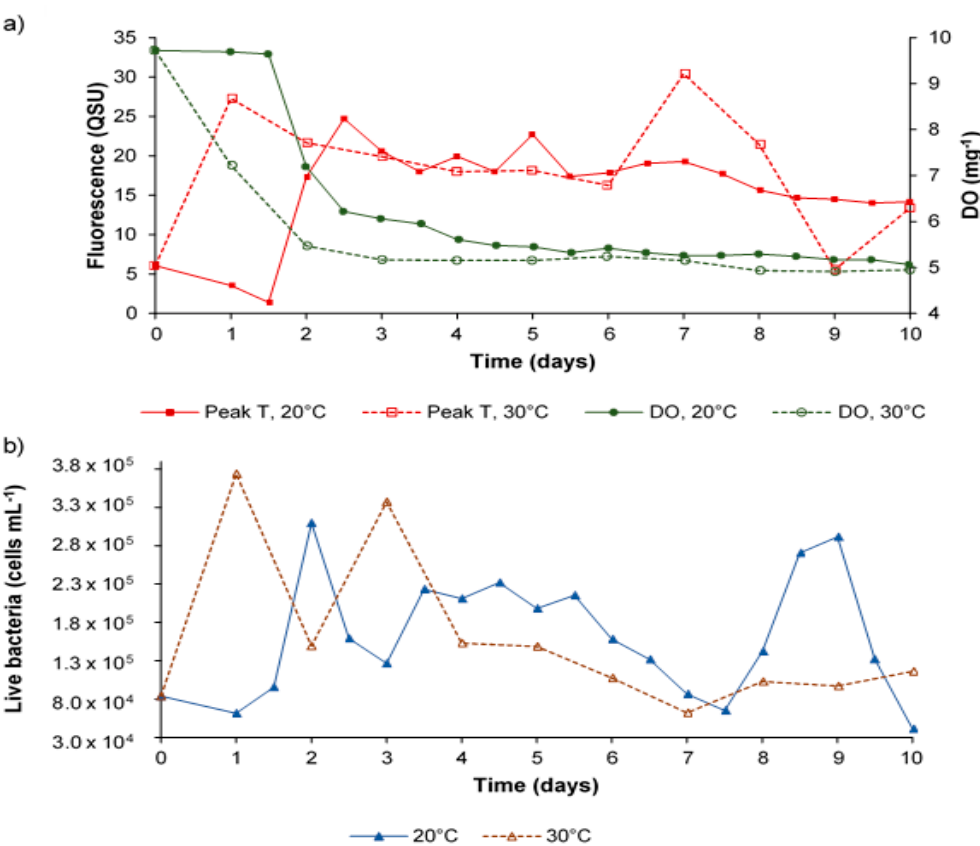
Figure 3. Data for synthetic water samples incubated at 20 ◦ C and 30 ◦ C over a 10-day microbial processing period: showing ( a ) Peak T fluorescence and dissolved oxygen and; ( b ) the number of living bacteria (cells mL − 1 ).